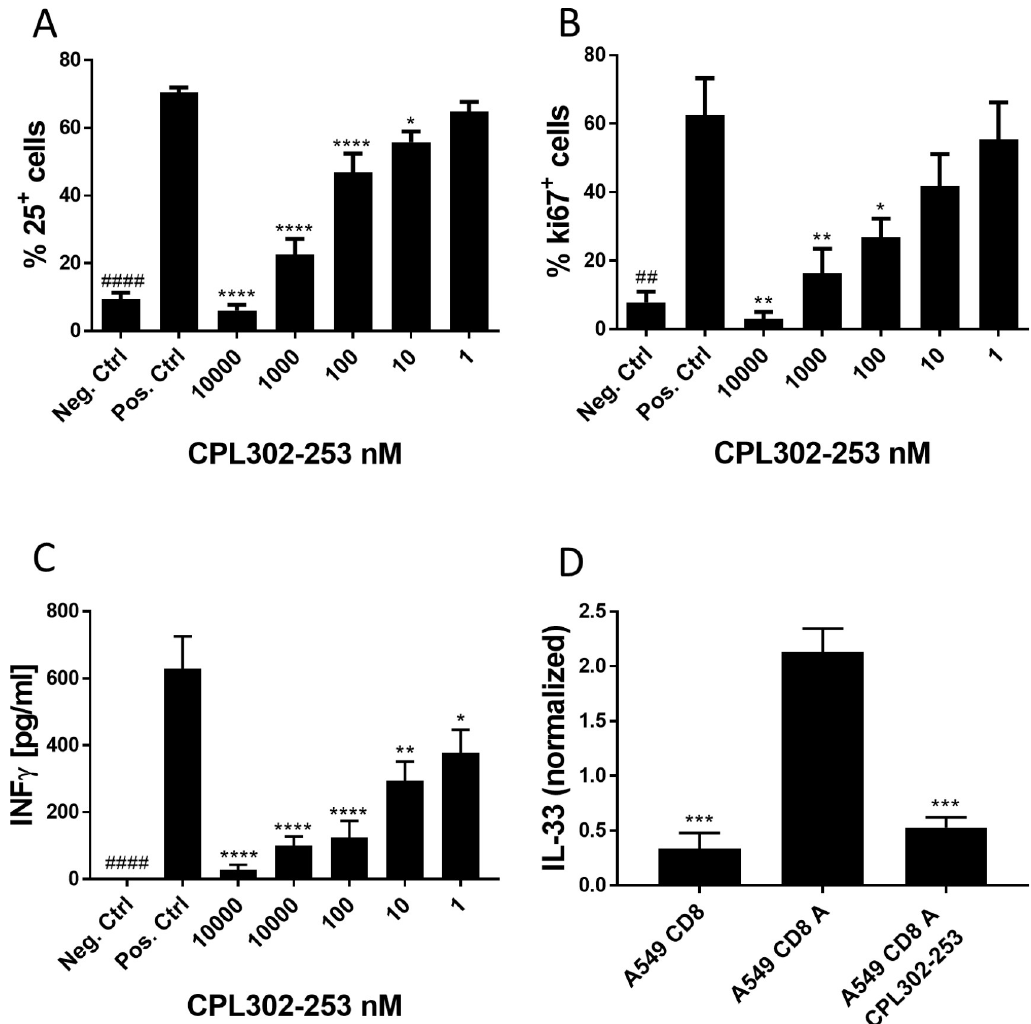
Fig 3. CLP302-253 blocks activation of primary lymphoid cells in vitro . (A and B) B cells were activated with ODN2006 and α IgM F(ab’) 2 for 72 h. To some cultures, CPL302-253 was added. (A) Expression of and activation marker CD25 and (B) proliferation marker ki-67 was assessed by FACS. (C) CD8 T cells were activated with α CD2, α CD3 and α CD28. IFN γ release was measured after 48 h in culture supernatants by ELISA. (D) A549 cells were co-cultured with na ï ve CD8 or activated CD8 cells. To some cultures CPL302-253 was added at 1 μ M. IL-33 expression was assessed after 72 h of treatment in CD8 and A549 cell lysates by ELISA. For each experiment at least three independent biological replicates were performed. p-value < 0.05 was regarded as significant response. � p-value < 0.05; �� p-value < 0.01; ��� p-value < 0.001. Neg. Ctrl–na ï ve cells, Pos. Ctrl– activated